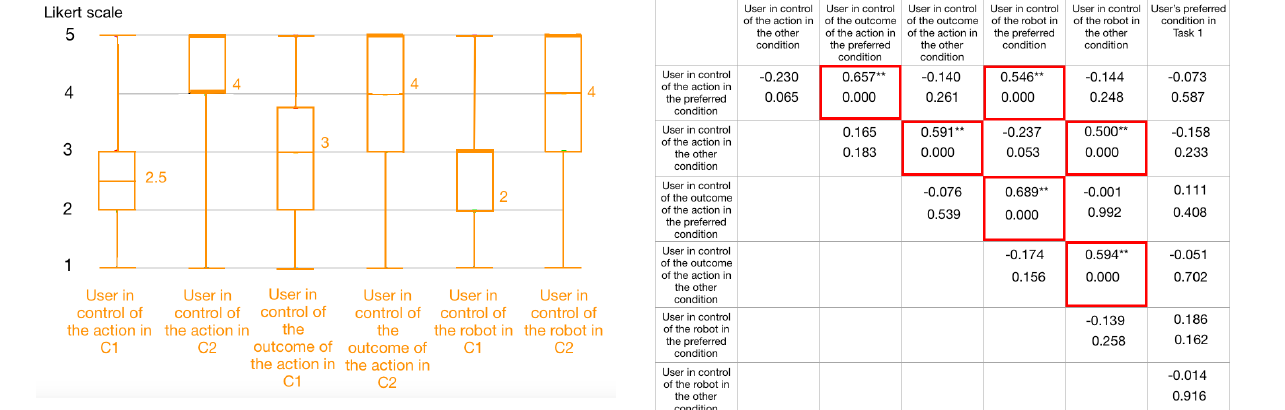
Figure 10: Task 1: building a Lego character.